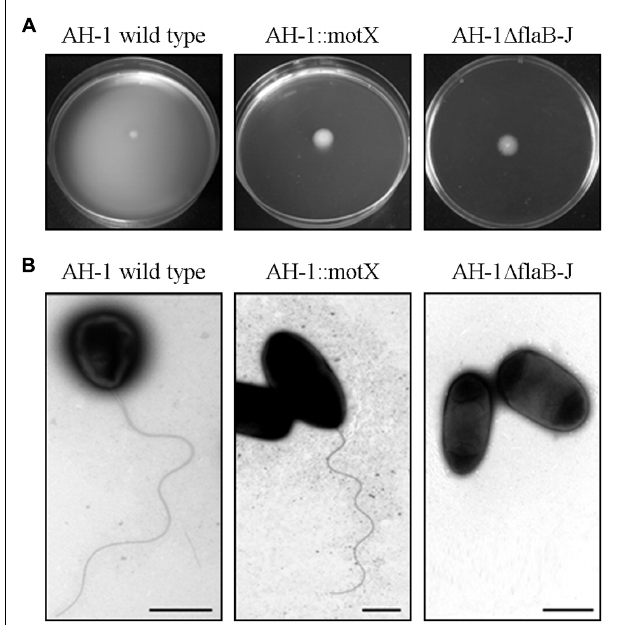
FIGURE 5 | (A) Motility swimming in semisolid agar plates of the strain AH-1 wild-type, AH-1::motX mutant (no motility), and AH-1 (cid:49) flaB-J mutant (polar flagella negative). (B) Transmission electron microscopy (TEM) of A. hydrophila strains. Bacteria were gently placed onto Formvar-coated copper grids and were negatively stained using a 2% solution of uranyl acetate. Bar = 1 µ m.